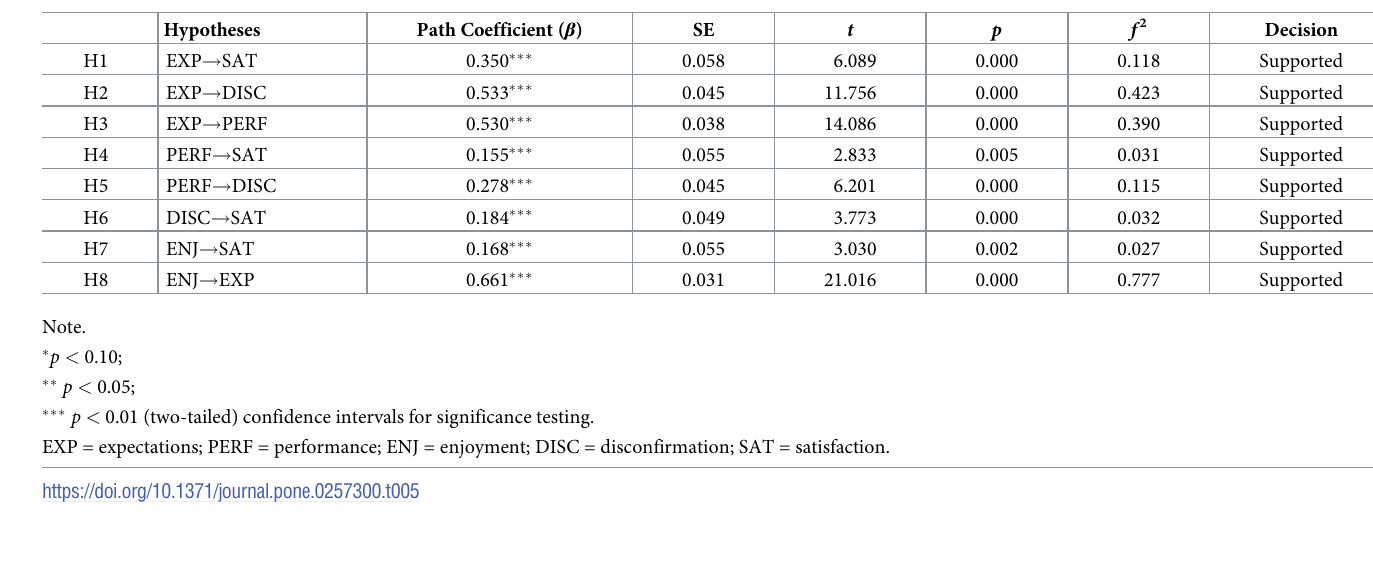
Table 5. Structural model